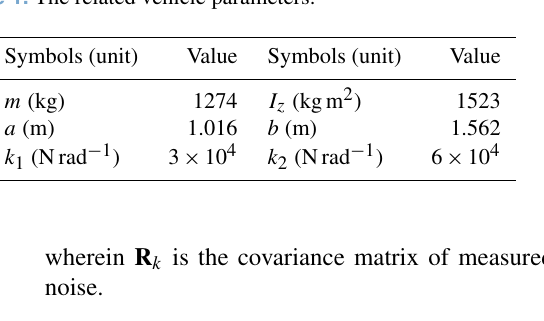
Table 1. The related vehicle